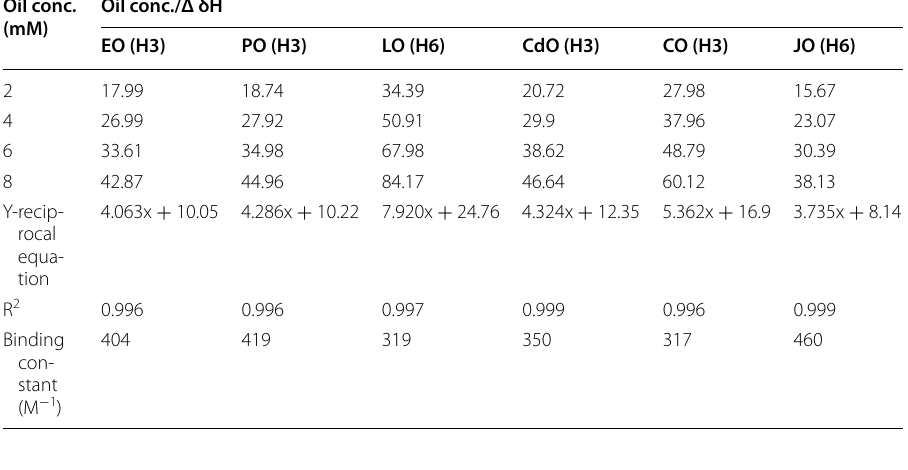
Table 3 1 H-NMR data of oil conc/ΔδH for binding constants between ICs of Eos & β-CD CA Oil conc. (mM)